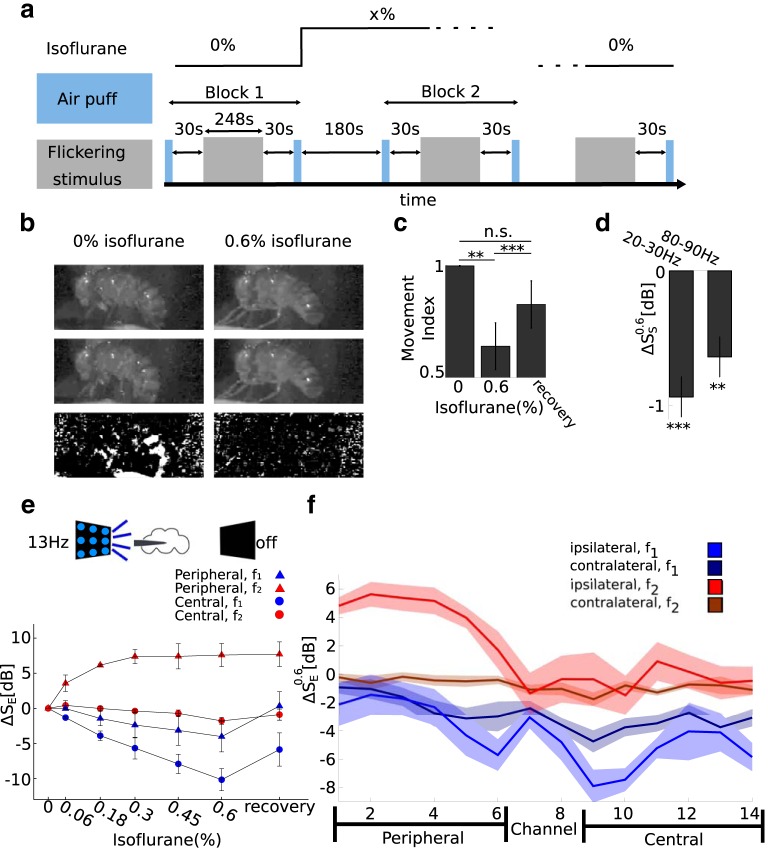
Isoflurane anesthesia has region- and harmonic-dependent effects on SSVEP power. a, Experimental protocol. An experiment consisted of multiple blocks, each at a different concentration of isoflurane (top black line). Each block proceeded with (1) air puffs (light blue rectangles); (2) 30 s of rest; (3) 80 trials of flicker presentation, corresponding to 10 presentations for each of the eight flicker configurations (gray rectangles); (4) 30 s of rest; (5) air puff; (6) isoflurane concentration change; and (7) 180 s of rest for adjustment to the new isoflurane concentration. b, Isoflurane abolishes behavioral responses. Consecutive video frames (first and second row) in response to an air puff before any anesthesia was administered (0%, left column) and before 0.6% isoflurane exposure (right column). In 0% isoflurane, flies respond to the air puff by moving, which is seen as the large difference in pixel intensity between consecutive frames (left, third row). After 0.6% isoflurane exposure, flies do not respond to the air puff, and there are only small differences between consecutive frames (right, third row). c, Quantifying behavioral responses. Group average (N = 13) movement index (see Movement analysis) was reduced during exposure to 0.6% isoflurane and rebounded after isoflurane levels were reset to 0%. Error bars represent the SEM across flies. d, Isoflurane reduces spontaneous brain activity (ΔSs), measured over four segments of 2.3 s before the start of the presentation of the visual stimuli. Group average (N = 13) effect of 0.6% isoflurane on spontaneous power (ΔS0.6S; see Local field potential analysis). Power is averaged across all channels. The average power for 20–30 and 80–90 Hz is significantly reduced. Error bars represent the SEM across flies. e, Isoflurane reduces SSVEP power (ΔSE) at f1 but increases power at f2 in a concentration-dependent manner. SSVEP power at f1 = 13 Hz (blue) and f2 = 26 Hz (red) for the [13 off] flicker configuration (indicated by the schematic above), at increasing concentrations of isoflurane. For each fly, the SSVEP is first averaged over peripheral channels (triangles, channels 1–6) or central channels (circles, channels 9–14). The channel average is further averaged across flies (N = 3). Error bars reflect the SEM across flies. f, Isoflurane increases SSVEP power at f2 for ipsilateral but not for contralateral flicker configurations. Spatial profile of SSVEP power at f1 (blue) and f2 (red) for contralateral (dark) and ipsilateral (light) flicker configurations in 0.6% isoflurane (ΔS0.6E). SSVEP power is averaged across ipsilateral or contralateral flicker configurations (Fig. 3a,b) first, then is averaged across flies (N = 13). Shaded areas represent the SEM across flies. The SSVEP power at f1 is reduced in central channels for all flicker configurations, indicating an effect on global neural processing. In contrast, SSVEP power at f2 is increased at the periphery, but only for ipsilateral flicker configurations, indicating an effect on local neural processing. The peripheral and central channels over which the average was taken in e are depicted at the bottom of f. ***p < 0.001 and **p < 0.01 in c and d.